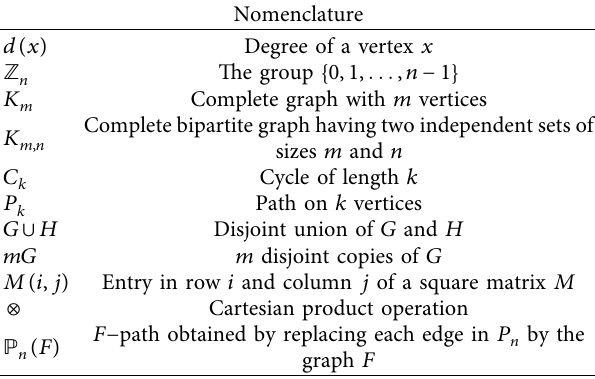
Table 1: Te nomenclature used in the